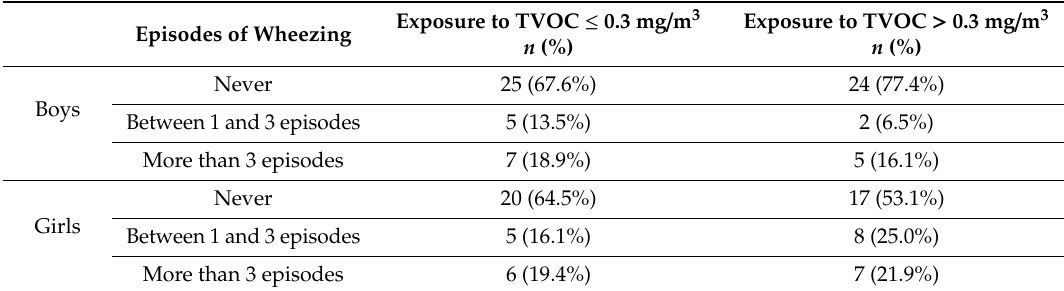
Table 5. Odds ratio and adjusted odds ratio for association of exposure to indoor smoking and di ff erent number of episodes of wheezing. Table 3. Indoor air quality parameters, outdoor air quality parameters, and indoor/outdoor (I/O) ratios. (Legend: n = 131, except for § where n = 128 valid cases; ⸸ where n = 109 valid cases; ¥ where n = 121 valid cases).